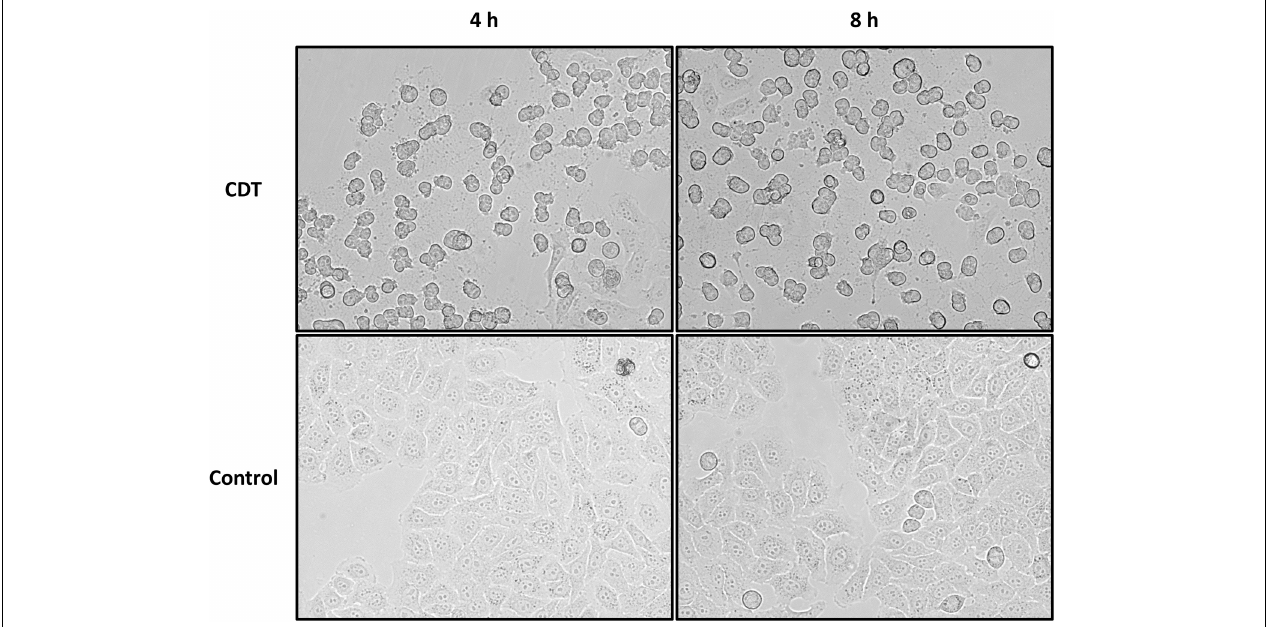
FIGURE 1 | Morphology changes of HEp-2 cells after 4 and 8 h of CDT treatment. Cells were treated with 1.5 µ g/mL of CDTa and 3 µ g/mL of CDTb; controls were